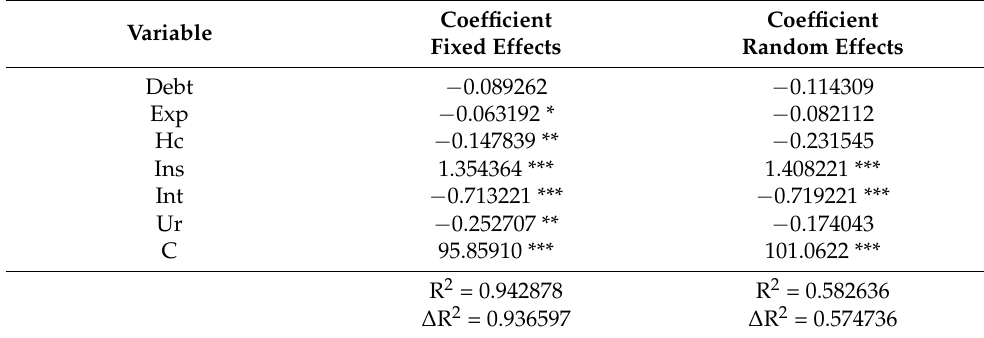
Table 6. The regression linear model (EU-ALL). Variable